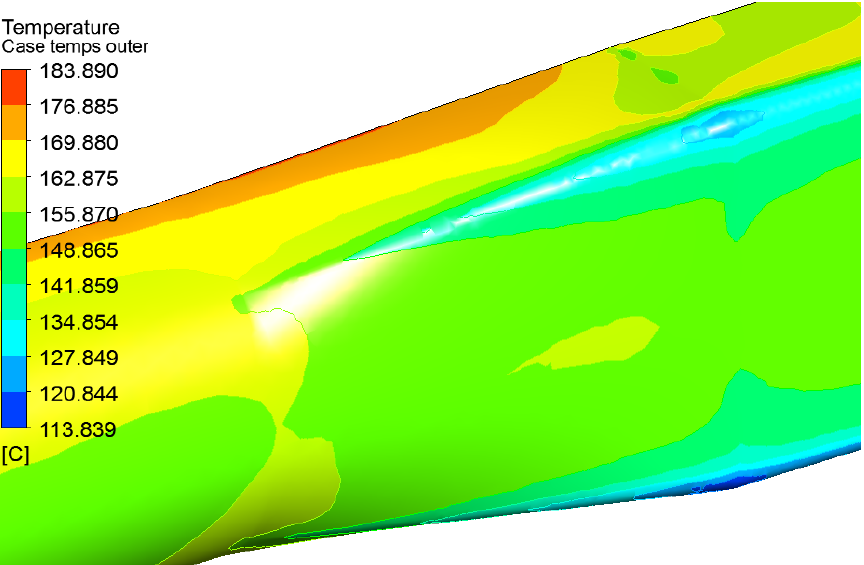
Figure 2. Temperature distribution on the surface of the experimental heat exchanger cone.